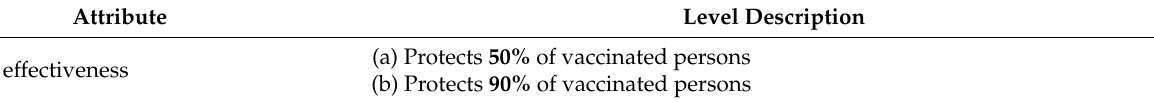
Table 2. Details and descriptions of the attributes and levels used in the discrete choice